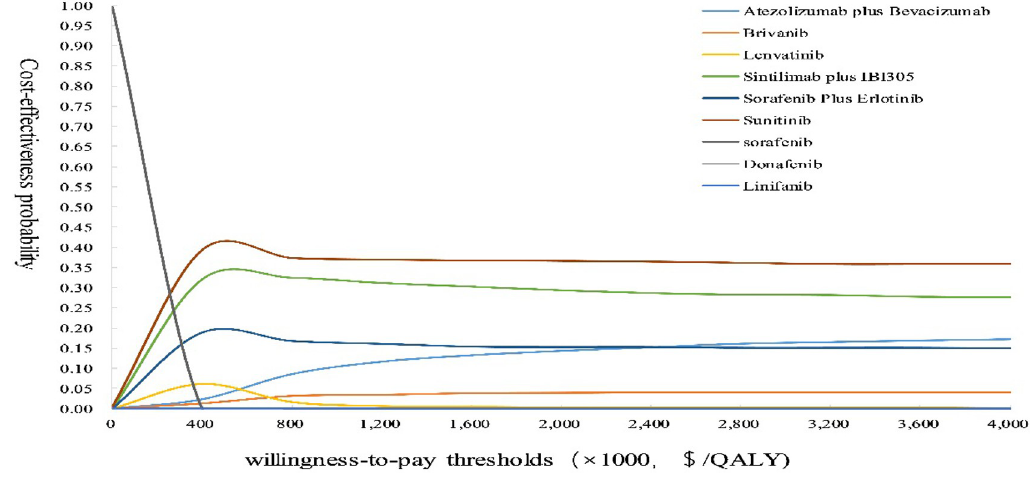
Fig 2. Cost-effectiveness acceptability curves. QALYs, quality-adjusted